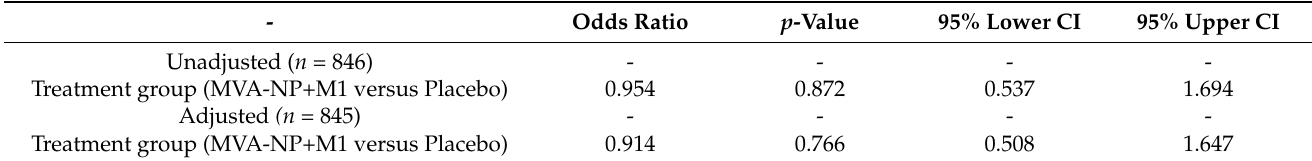
Table 2. Primary Outcome (ITT). Unadjusted and Adjusted Linear Mixed Effect Model for Presence of Moderate or Severe Symptoms.